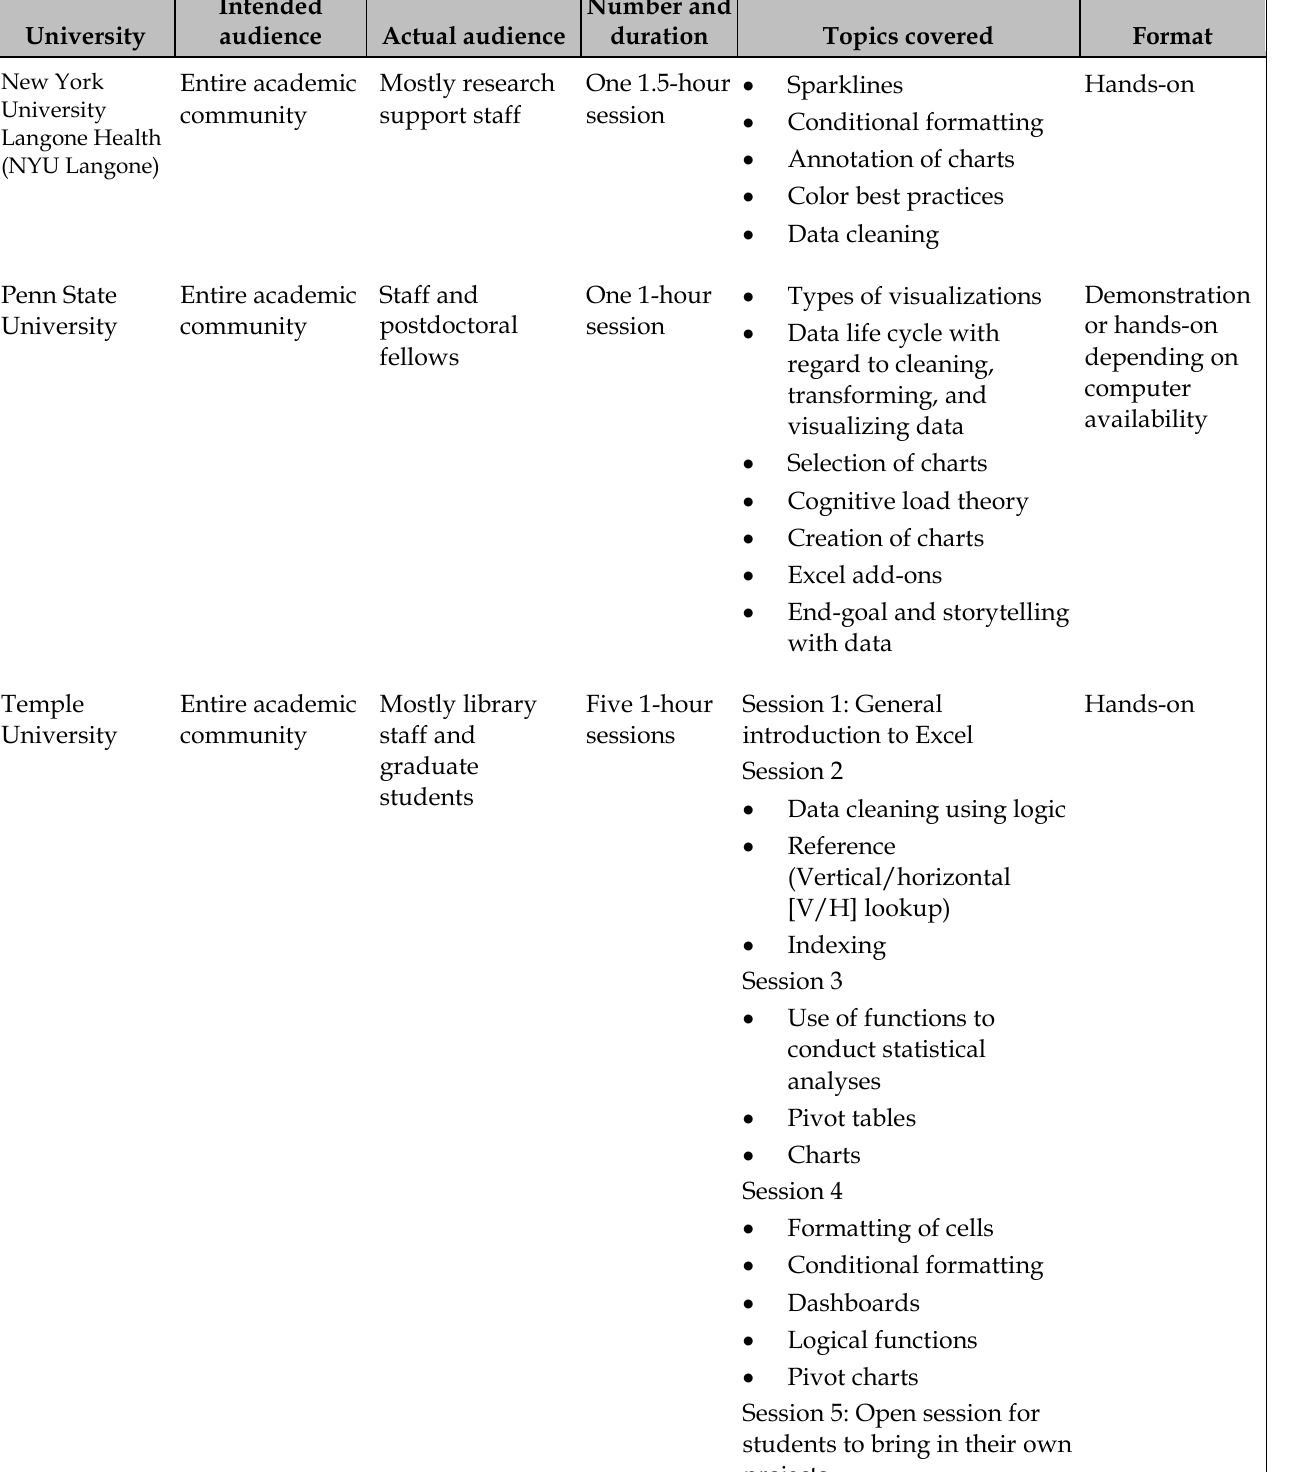
Table 1 Description of Excel-focused data visualization workshops offered by eight